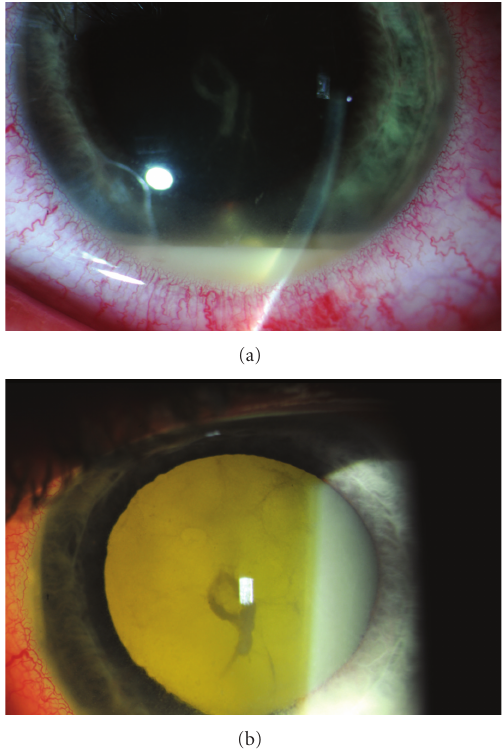
Figure 1: External photograph on initial presentation to Vander- bilt illustrating hypopyon (a) and retroillumination demonstrat- ing dense vitreous opacities (b).